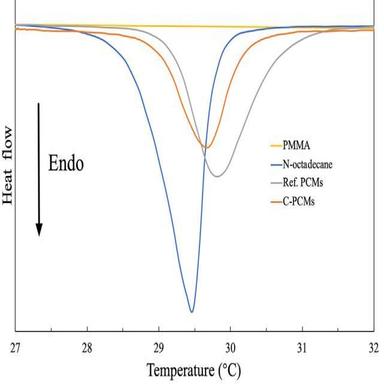
DSC curves of PMMA, N-octadecane, Ref. PCMs, C-PCMs.